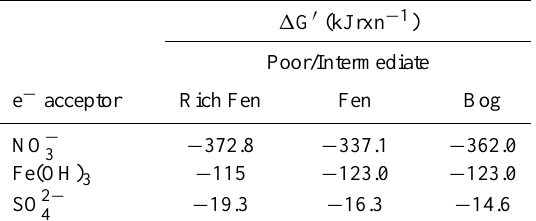
Table 1. Gibbs Free Energy ( 1 G 0 ) for AOM across a trophic gra- dient of peatland types using various inorganic electron acceptors. Calculations assume standard conditions and the following peat porewater ion concentrations. Rich fen values 1 : [CH 4 ] =